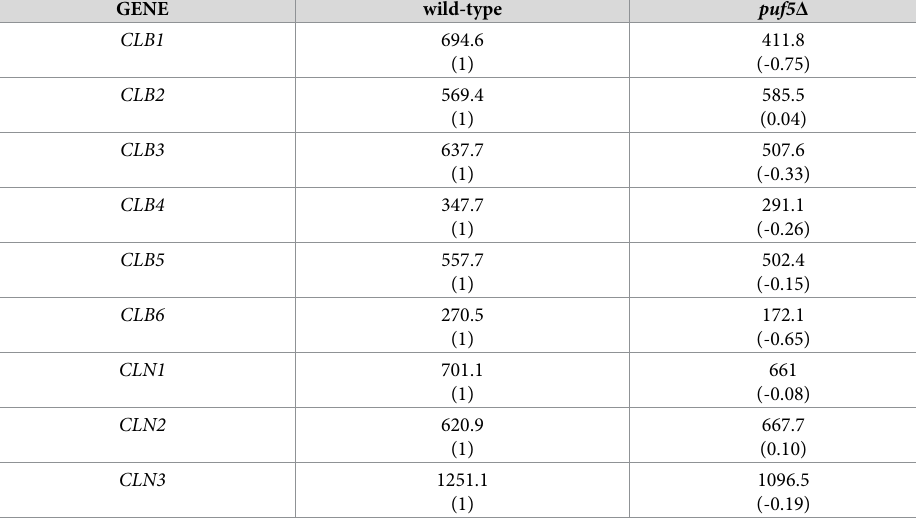
Table 1. The extract data of the expression of CLB and CLN from previous microarray data. The microarray data of each gene in wild-type and the puf5 Δ mutant strains are presented. The whole data is presented in (Valderrama et al., 2021) [32]. The log2 fold change of the expression of each gene in the puf5 Δ mutant normalized to that in wild- type are shown within